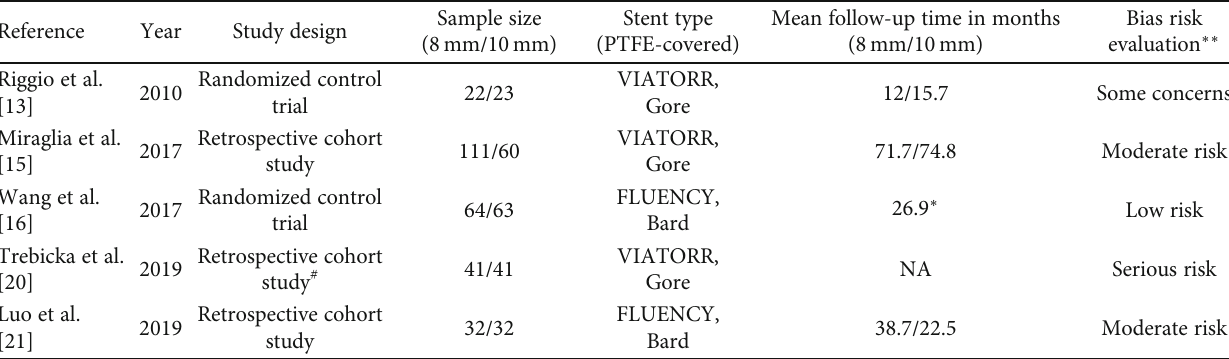
Figure 1: Flow diagram of the meta-analysis study selection process. Table 1: Study